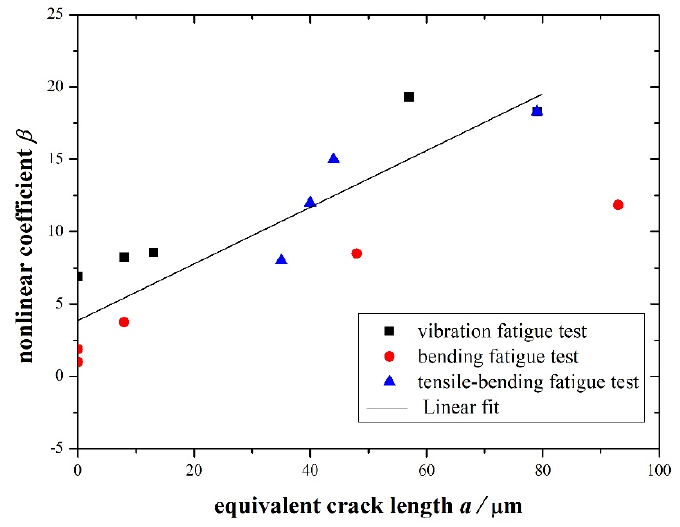
Figure 13. Relationship between nonlinear coefficient and crack propagation size. ( R 2 = 0.79).